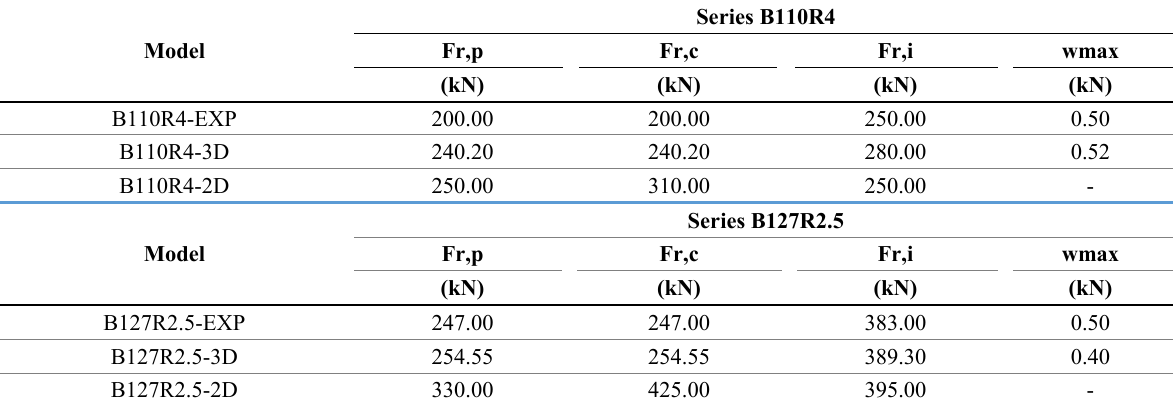
Table 6. Loads related to the opening of cracks and maximum cracks of the numerical models (two-dimensional and three- dimensional) and experimental models